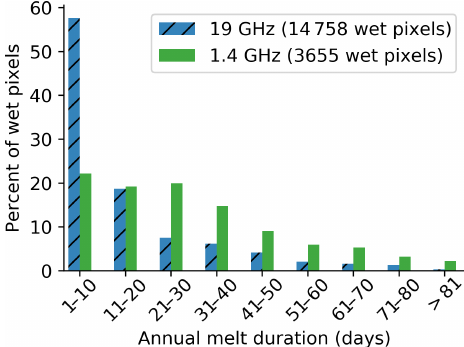
Figure 4. Annual melting duration distribution of wet pixels de- tected with 1.4GHz (solid green) and 19GHz (hatched blue) over the whole continent of Antarctica for each summer season from 2010 to